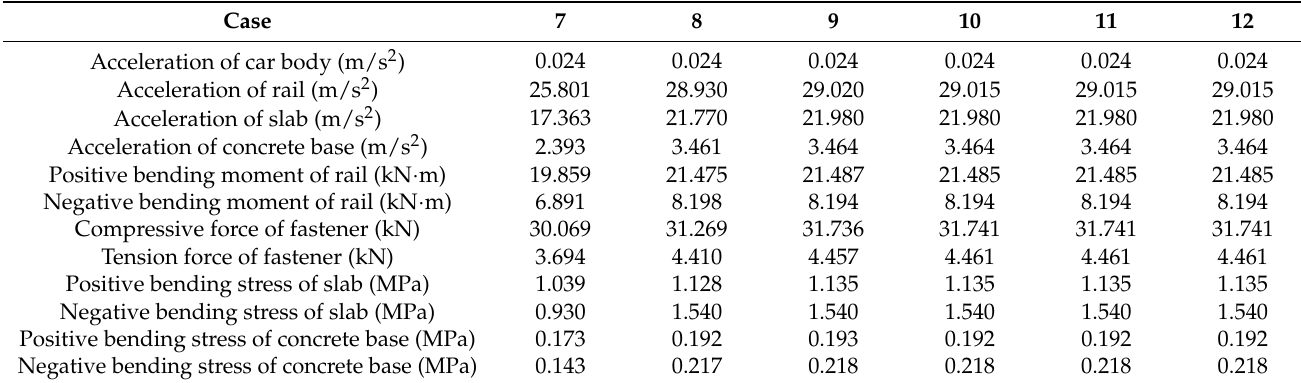
Table 6. Largest dynamic responses for Cases 7–12.